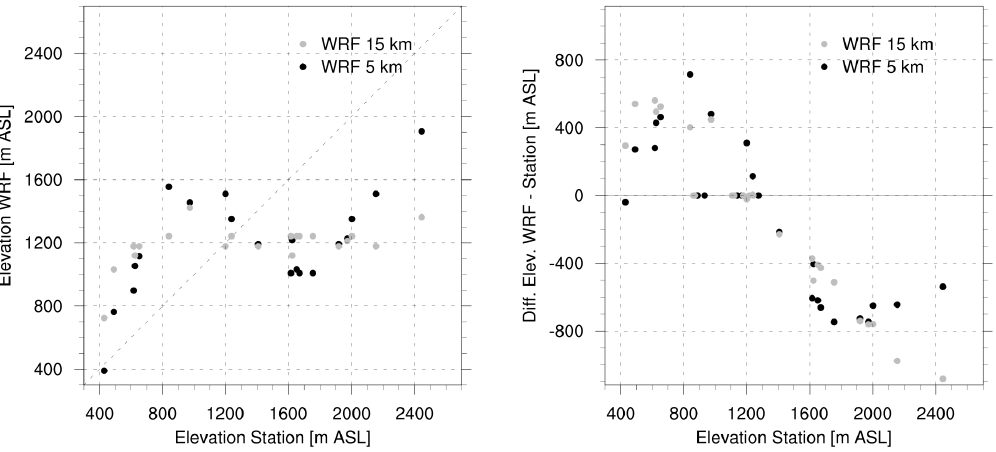
Figure 8. Elevation differences between WRF model grid cells and the corresponding measurement stations for the domains D2 (15 km) and D3 (5 km). The left figure shows scatter plots for the two domains, the right one displays the differences between model cell and station elevation depending on absolute elevation of the